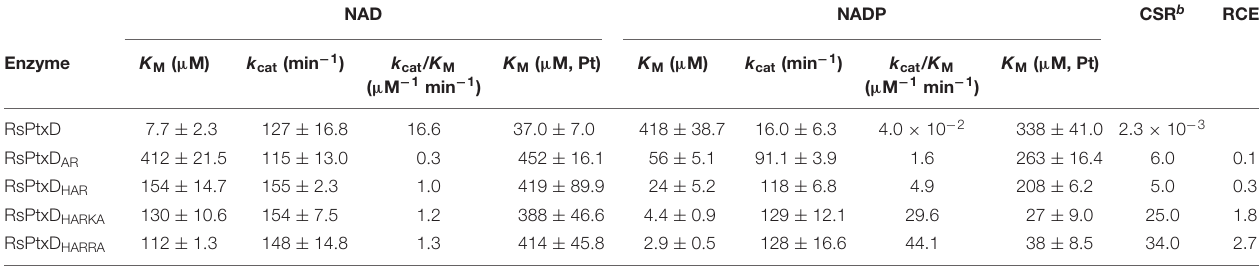
TABLE 1 | The kinetic parameters of wild-type RsPtxD and its mutants a .